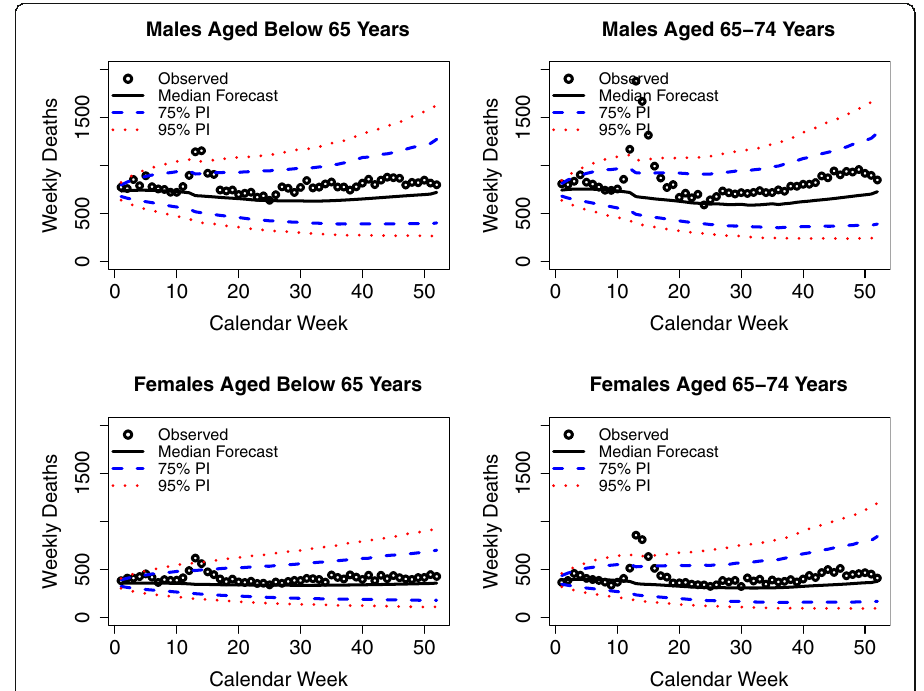
Fig. 16 Observed and predicted weekly death numbers in 2020 in Spain by sex and age below 75 years of age. Sources: Human Mortality Database (2021); Computations and design by the authors